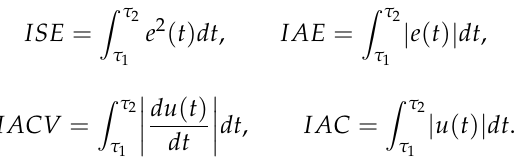
Table 4. Orthogonality condition x (cid:62) the parameter identification of the servo system model (54) using the LSOD